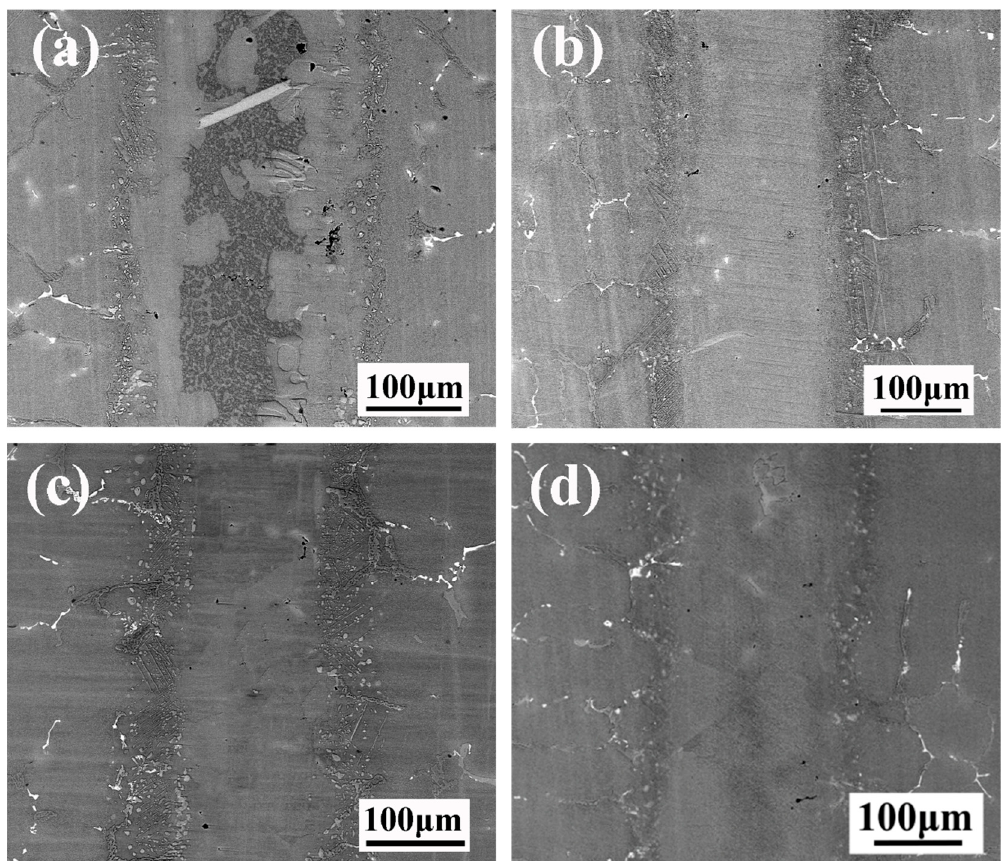
Figure 6. Effect of various durations on microstructure of the joints: Integral microstructure of the joints brazed at 1160 ° C for ( a ) 5 min;( b ) 30 min;( c ) 60 min; ( d ) 120 min.